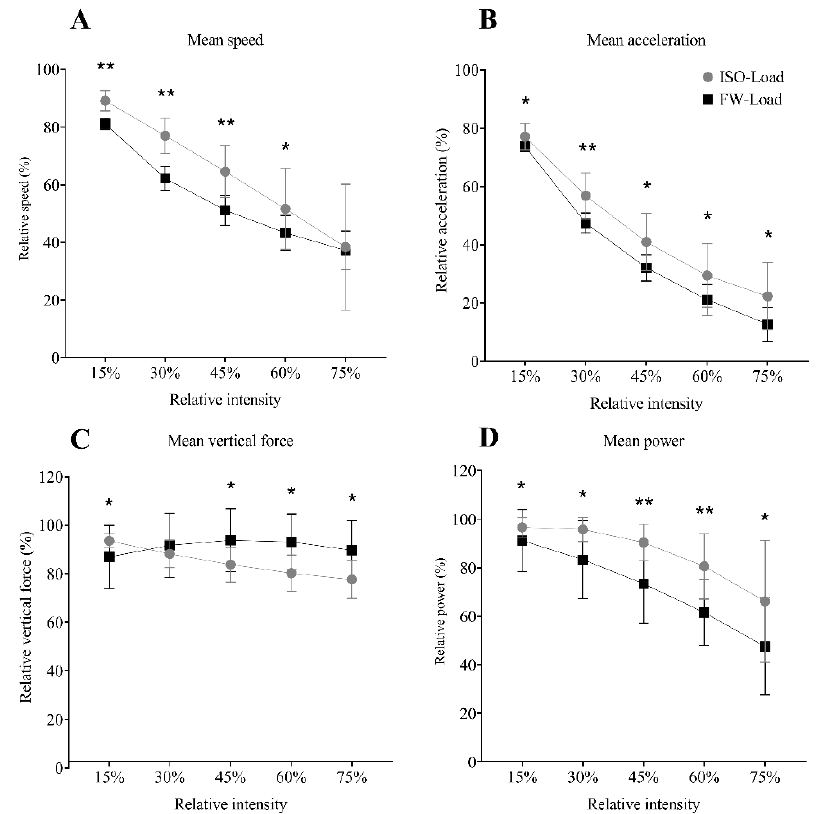
Figure 5. ( A ) Estimated data normalized from maximum speed; ( B ) acceleration; ( C ) vertical force, and ( D ) power for five relative intensities (training intensity continuum) for the flywheel (FW-load) and weight load types (ISO-load). Data points represent mean values, and error bars the standard deviation. Between loading condition differences are shown as: * = p < 0.05, ** = p < 0.001.